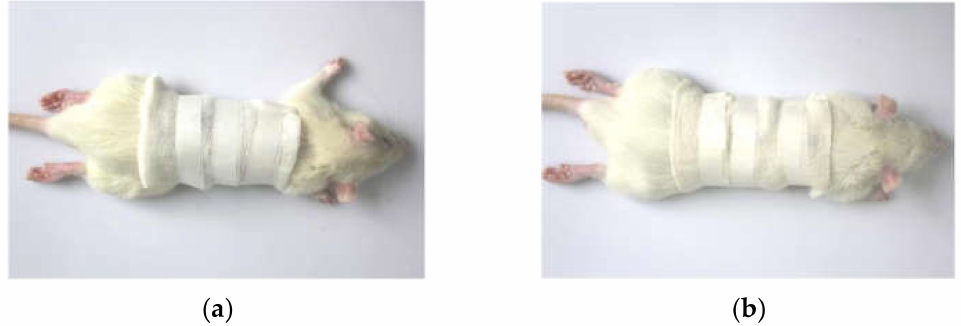
Figure 3. We wrapped the rats’ wound with two types of gauze: ( a ) conventional cotton gauze used for rats in the control group, and ( b ) brown cotton bleached gauze used for the experimental